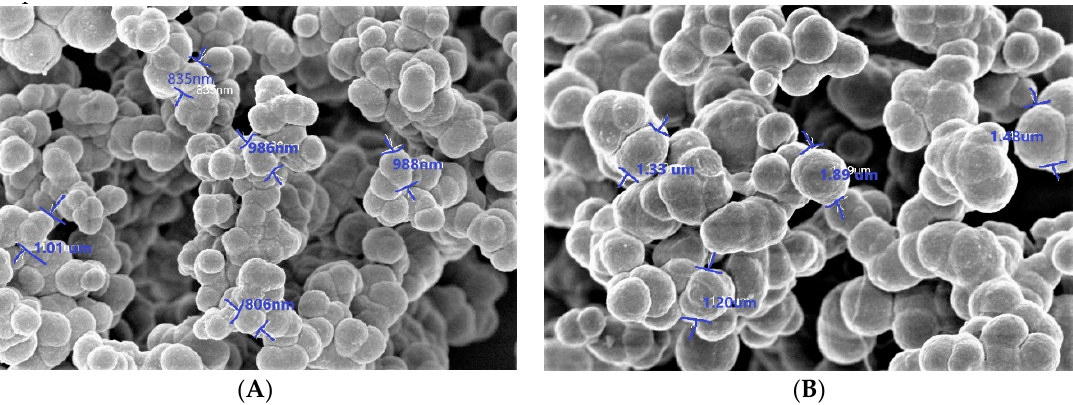
Figure 1. Scanning electron microscope (SEM) images of ( A ) non-imprinted polymers (NIPs) beads and ( B ) washed stimulus-responsive imprinted polymer (MIP)beads.